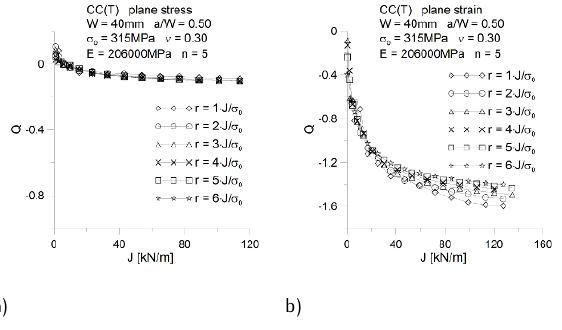
Figure 3. The J - Q trajectories measured at six distance near the crack tip for center cracked plate in tension specimen (CC(T)): a) plane stress; b) plane strain.